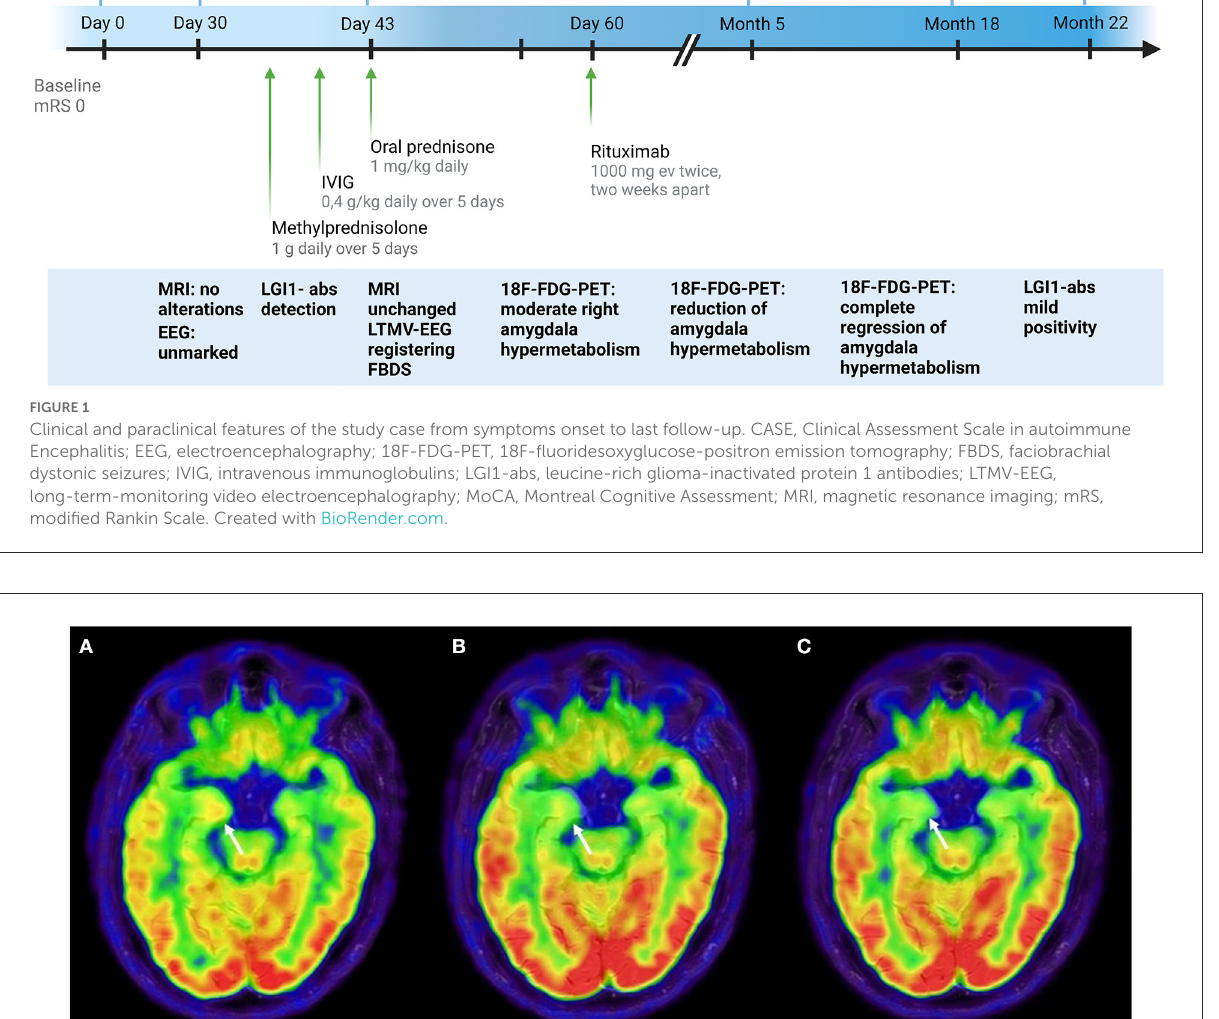
in revealing subclinical and relapsing seizures (12, 13). We could not exclude that the patient could further improve over time even without escalation to second-line therapy, also based